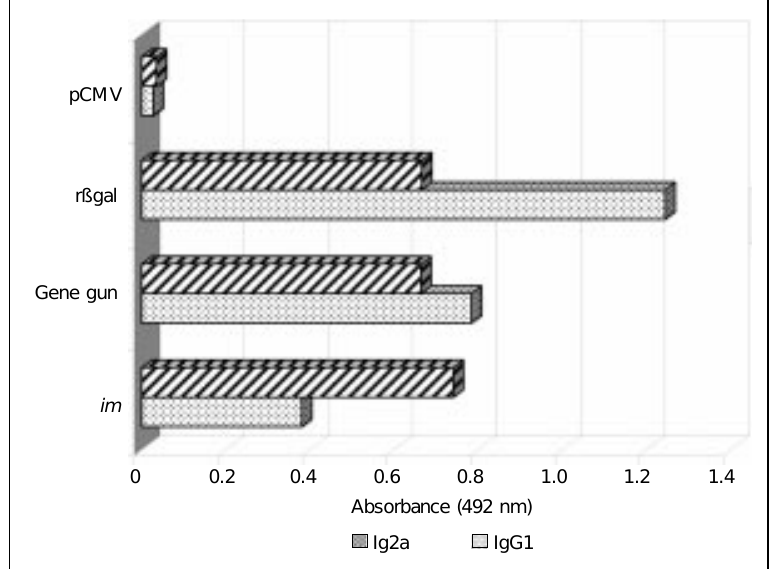
Figure 3 - Antibody profiles induced by im injection or gene gun vaccination with plasmid DNA compared to recombinant protein immunization. The IgG2a and IgG1 responses produced in BALB/c mice (five per group) were measured after gene vaccination with pCMV-ßgal or pCMV using the two gene delivery systems according to the protocol described in Figure 1. Antibody subclass responses were also detected following subcuta- neous injection of 10 µg of recombinant ß-galactosidase (rßgal) per animal plus incomplete Freund’s adjuvant. Mice were bled after the third immunization on day 45, and antibody levels were measured by indirect ELISA. Data are reported as mean values of